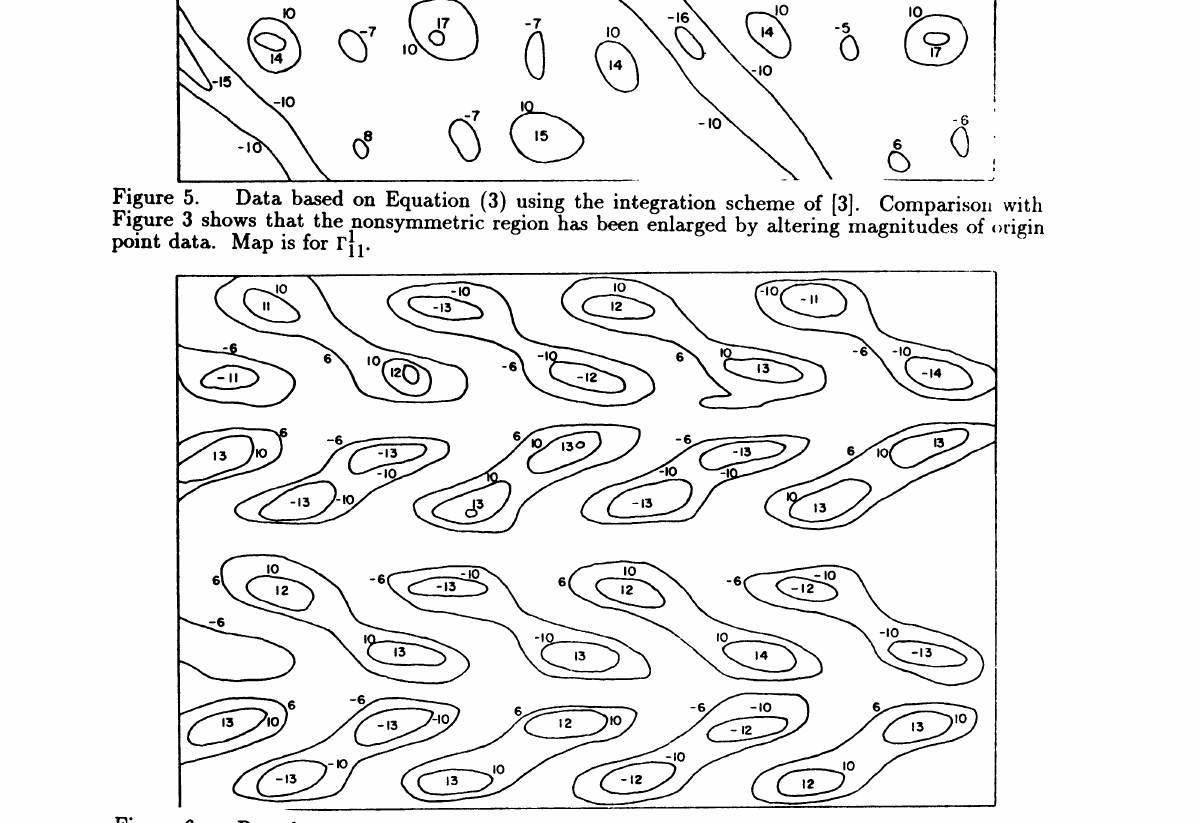
Figure 4. Data based on Equation (3). Map is obtained by specification of path by integrating along z, then y, then z. Grid is .075. z is equal to -.3. Results indicate lattice that is stationary in time. Map is for rl.